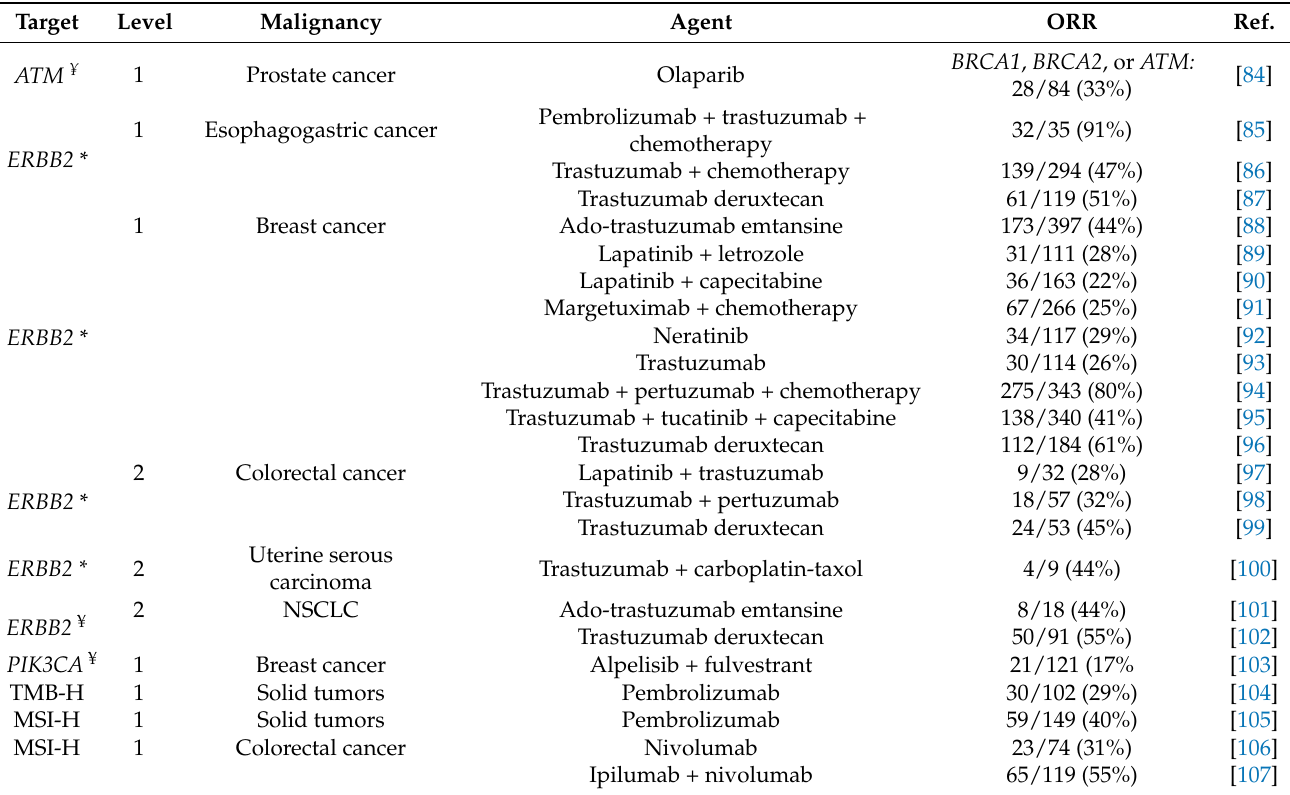
Table 4. FDA-approved drugs targeting genetic alterations in other malignancies.